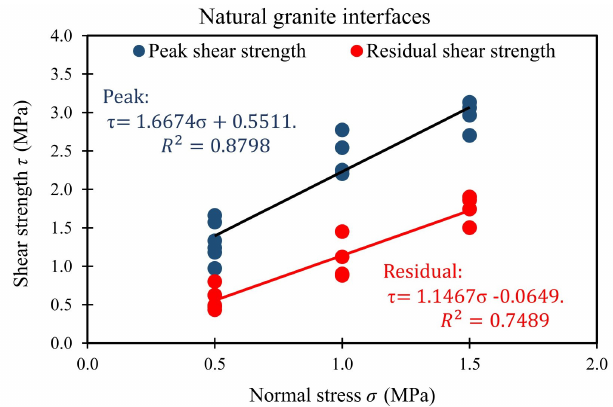
Figure 14. Peak and residual shear strengths in terms of normal stress (natural granite